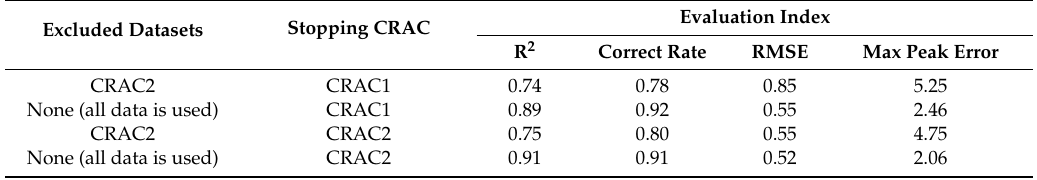
Table 19. Evaluation values when the CRAC2 dataset was excluded from the training